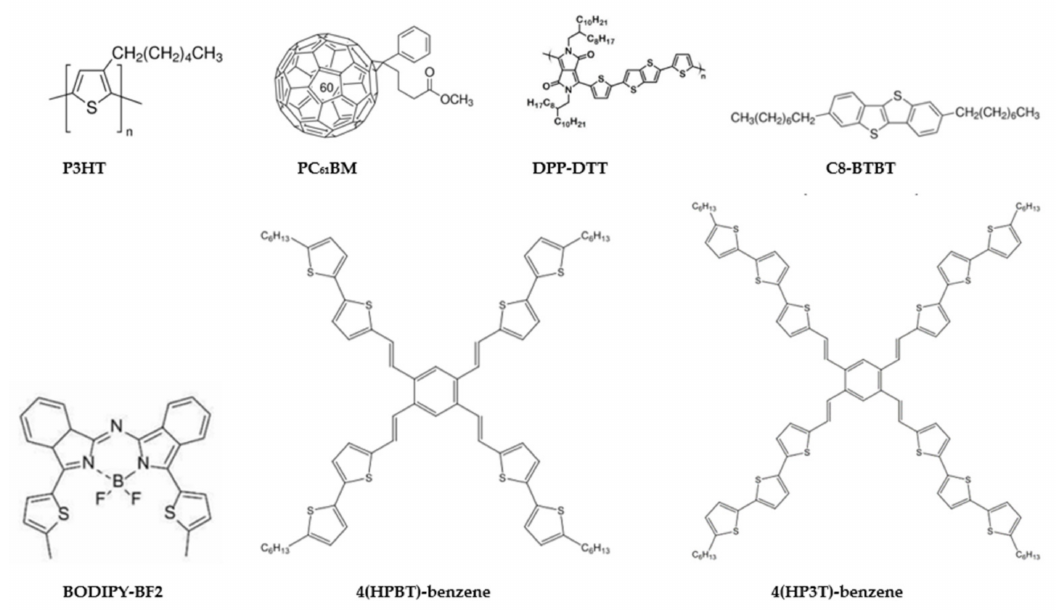
Figure 13. Chemical structures of some solution-processed small molecules and polymers used in OPT